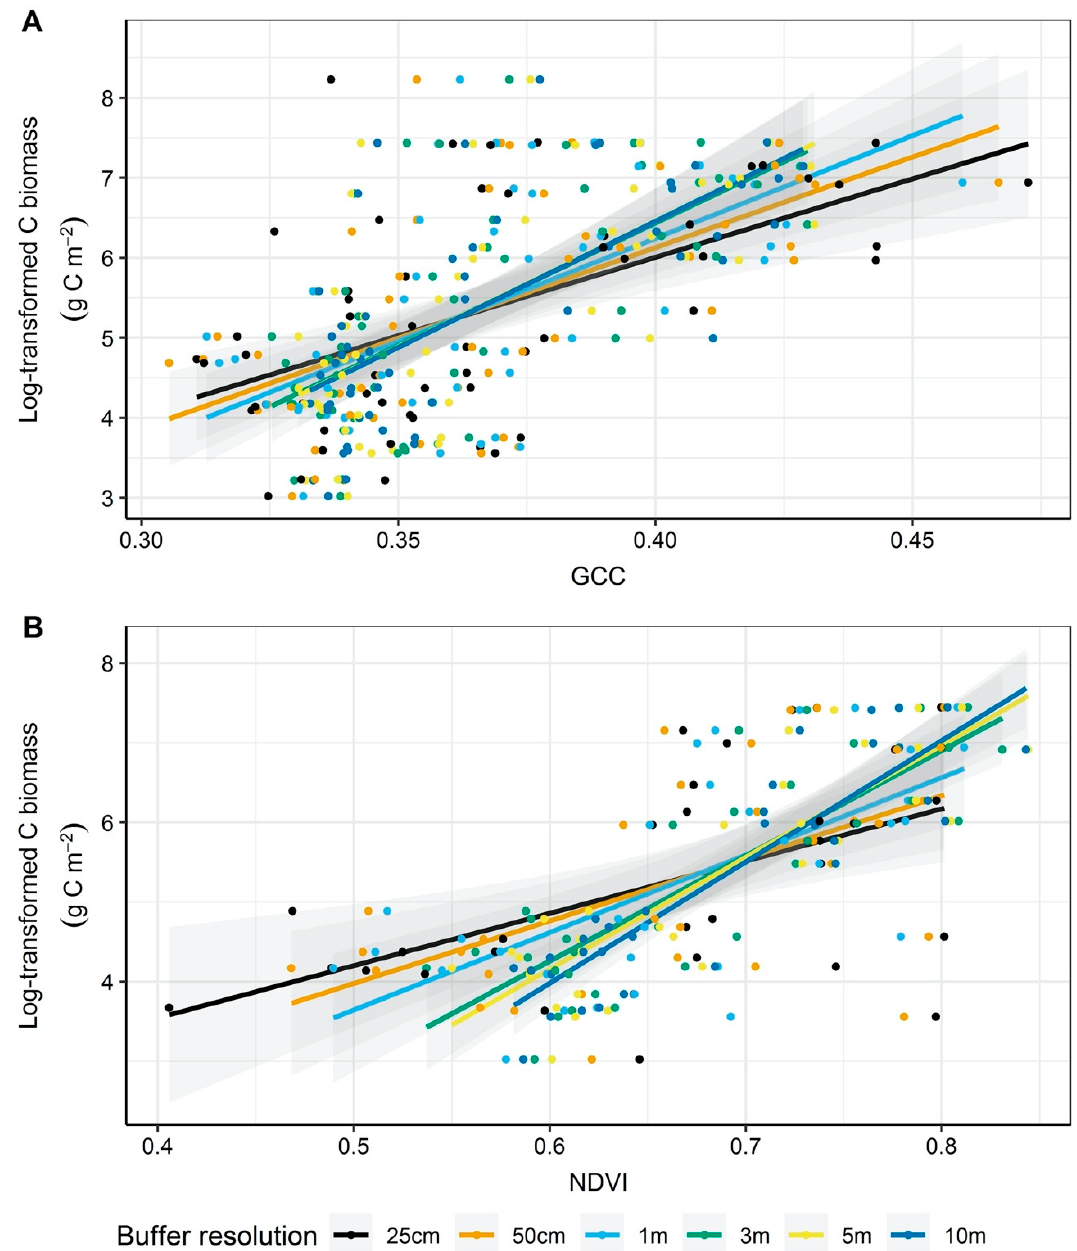
Figure 3. Linear models testing how well log-transformed aboveground carbon biomass (C mass) is predicted by GCC ( A ) and NDVI ( B ) across increasing spatial resolutions. C mass includes trees and tall deciduous shrubs. Vegetation index values were an aggregated mean extracted at an increasing buffer radius (buffer resolution). Panels show fitted relationship with 95% confidence intervals and raw point data. NDVI ( B ) was a stronger predictor of C biomass than GCC ( A ) based on adjusted R 2 (Table 4). The analyses showed that basal area of shrubs and trees increased with increasing GCC and NDVI (Figure 4; Table 5). Live tree basal area ranged from 0.00 to 34.57 m 2 per hectare (ha). Shrub basal area ranged from 0.87 m 2 per ha to 28.14 m 2 per ha. GCC was a poor predictor of live tree (R 2 = 0.14) and shrub basal area (R 2 = 0.29). NDVI was a strong predictor of live tree basal area (R 2 = 0.52), but a poor predictor of shrub basal area (R 2 =